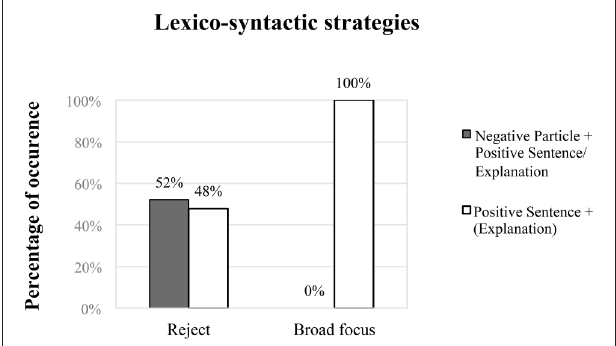
FIGURE 1 | Percentage of occurrence of lexico-syntactic strategies used by MC speakers in the two conditions (REJECT vs. BROAD FOCUS). Negative particles followed by positive sentences/explanation are displayed in gray columns, while positive sentences followed by explanation are displayed in white columns.